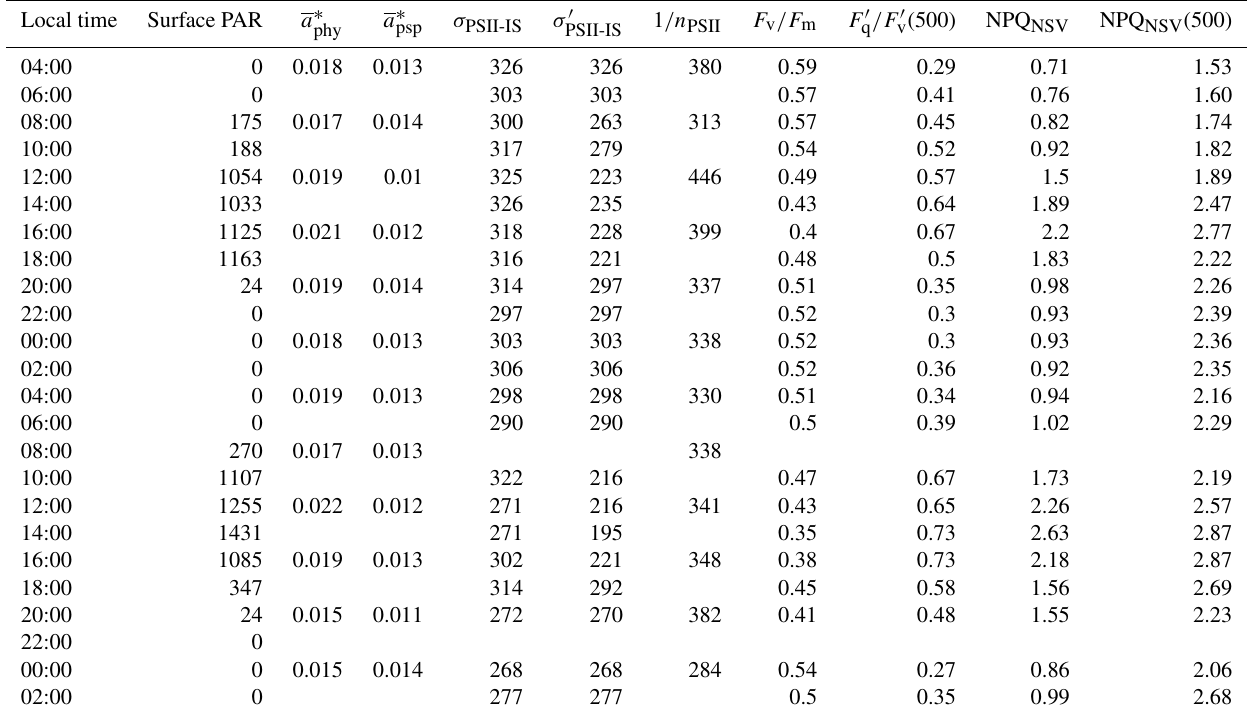
Table 2. Light absorption characteristics and PSII photo-physiology (process 1 in Fig. 1) for the 48h diurnal cycle at OCE17. Surface PAR (400–700nm, µmolquantam − 2 s − 1 ) during each sampling point. Chlorophyll a -specific absorption coefficients for phytoplankton , m 2 mgChl a − 1 ) and photosynthetic pigment ( a ∗ psp , m 2 mgChl a − 1 ), estimated using the HPLC pigment reconstruction approach and ( a ∗ phy weighted to the spectral quality of in situ light. The functional absorption cross section of PSII, derived for the dark-regulated state ( σ PSII-IS , Å 2 RCII − 1 ) and specific to in situ light quantity at each sampling point ( σ (cid:48) , Å 2 RCII − 1 ), both corrected to the spectral quality of in PSII-IS situ light. Estimates of the photosynthetic unit size of PSII (1 /n PSII , molChl a molRCII − 1 ). F v /F m , the maximum quantum efficiency of charge separation in RCII. F (cid:48) q /F (cid:48) v (500), an estimate of the fraction of “open” reaction centres ( Q A oxidized) at a reference irradiance